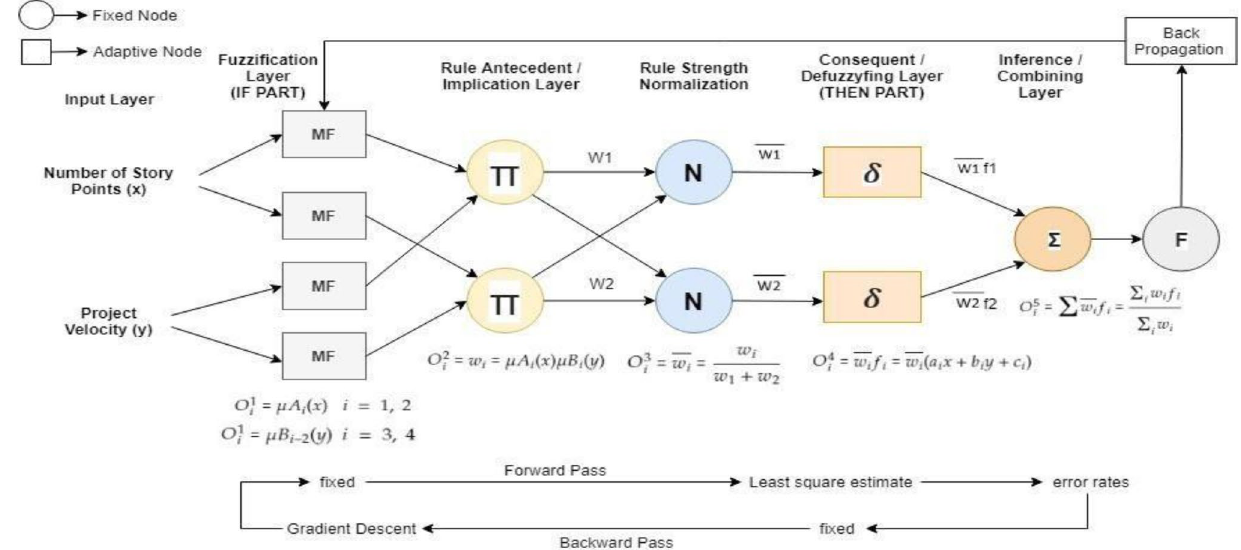
Figure 1. Standard ANFIS architecture. Number of Story Points and Project Velocity are given as inputs. These inputs have been derived from 21 projects dataset (dataset sample given in Table 2). ANFIS based exhaustive search MATLAB functionality has been used to decide the inputs. Different inputs (as feature pairs) tested against Actual Time. The feature pair with minimum error has been chosen in input